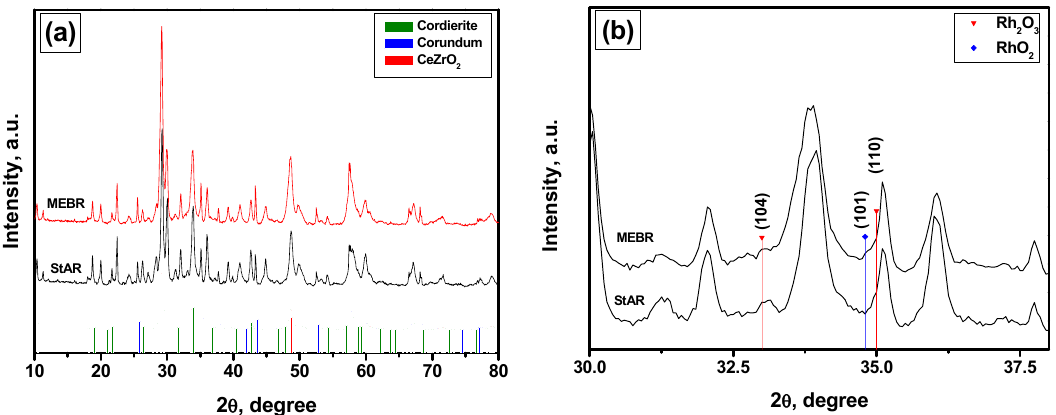
Figure 4. XRD patterns for the Rh / (Al 2 O 3 -CeZrO 2 ) catalyst aged at standard conditions (StAR) and in model engine braking regime (MEBR): ( a ) in a range of 10–80°; ( b ) in a range of 30–38°.